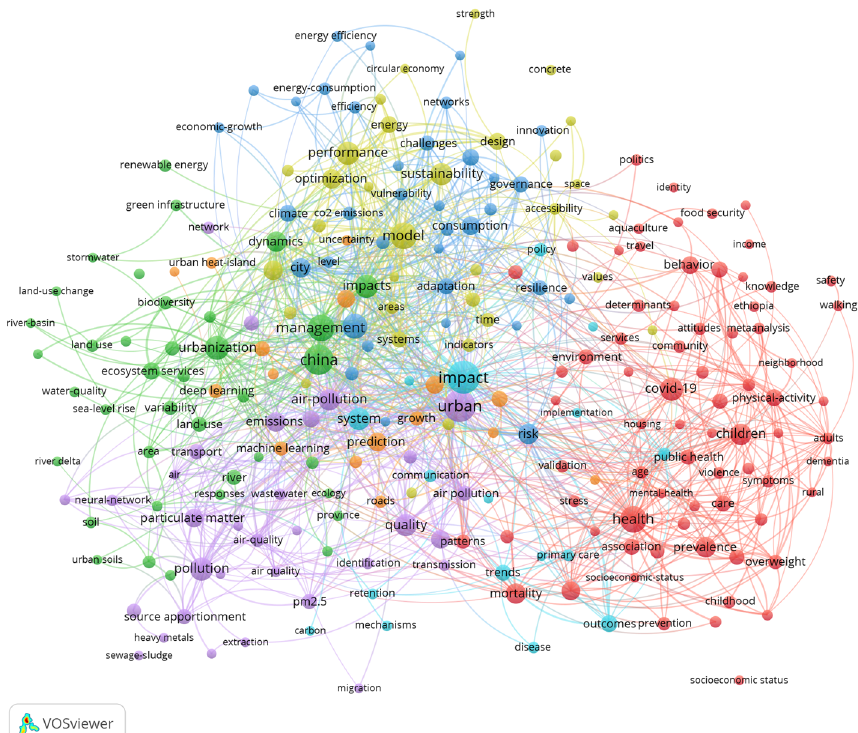
Fig. 1 Map of smart city development research clusters. Source :